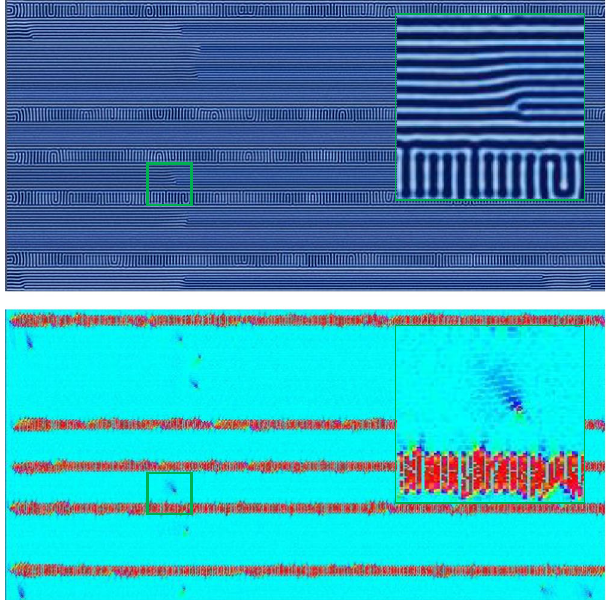
Figure 10. Same as Fig. 9 but with a zone velocity of v zone = 0.215. At this velocity, the lamellae prefer a perpendicular orientation, which is restricted somewhat by the template pattern. A few bands of perpendicular lamellae develop between the template